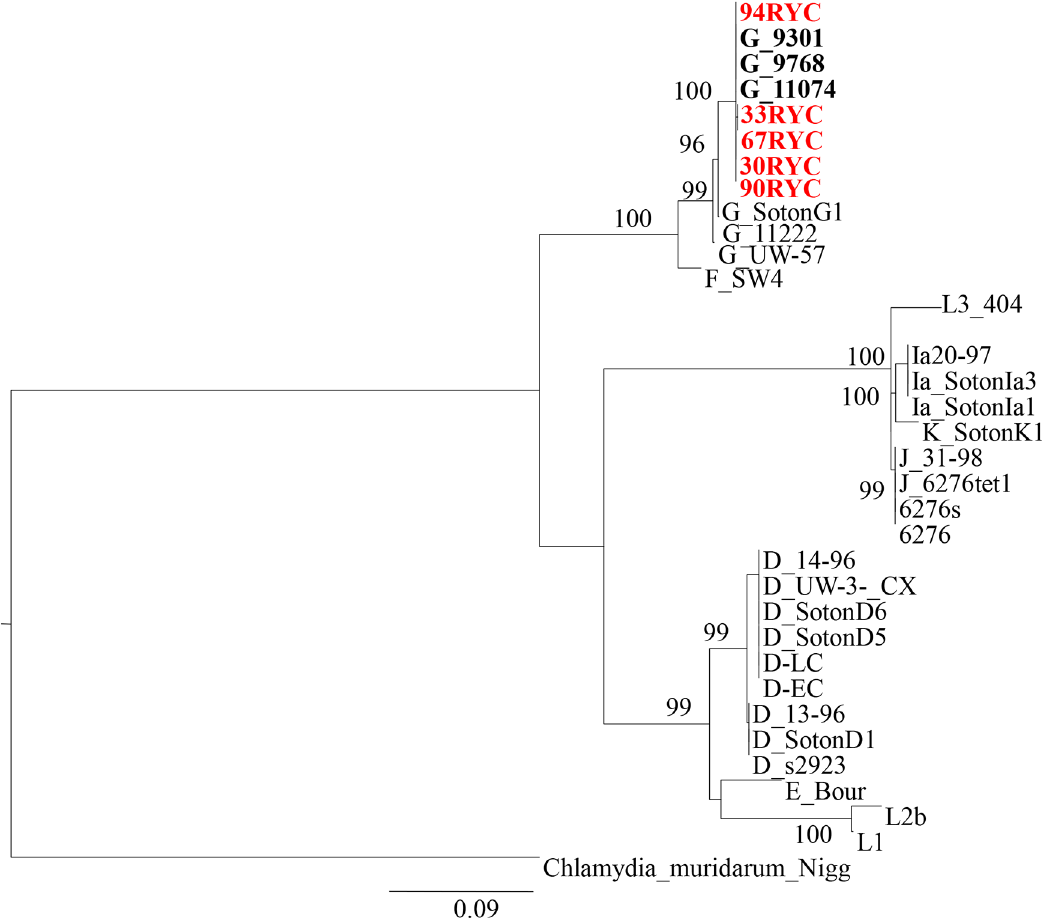
Fig 2. Maximum likelihood phylogenetic reconstruction (PhyML) based on concatenated pmpH-ompA genes. The strain carrying the putative pmpH- recombinant variant found during this study (in red letters) is closely related to strains belonging to genotype G (bold). The general time reversible plus proportion of invariable sites and gamma distribution model (GTR+ I+G) was used. Numbers indicate bootstrap values based on 1000 replicates (%).